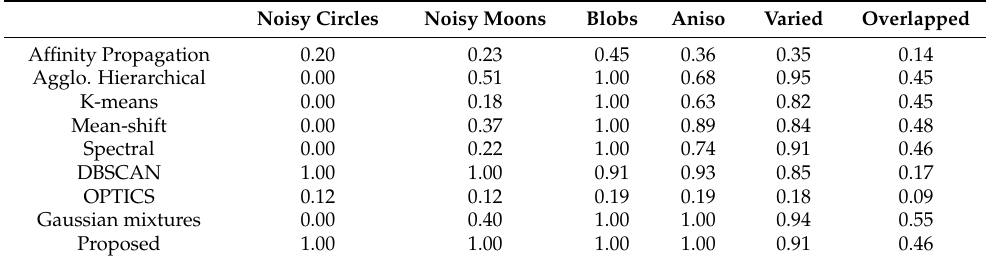
Table 5. The completeness of affinity propagation, agglomerative hierarchical, k-means, mean-shift, spectral, DBSCAN, OPTICS, Gaussian mixtures, and the proposed clustering methods on noisy circles, noisy moons, blobs, anisotropic, varying variance, and overlapping datasets.